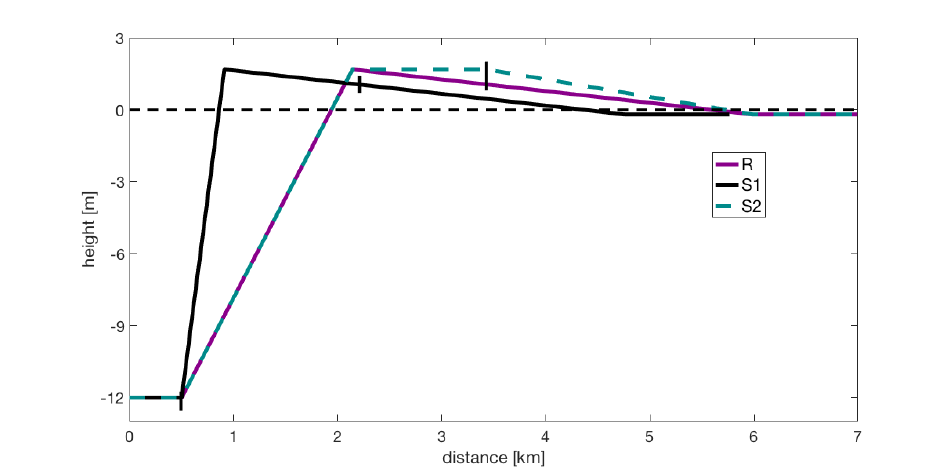
Figure 3. The seaward and landward slope configurations for R , S 1, and S 2 used for the simulations. The vertical black bars indicate the extend of the normalized grid, used in the ensuing figures in Section 3, from the start of the slope until 1.3 km after the